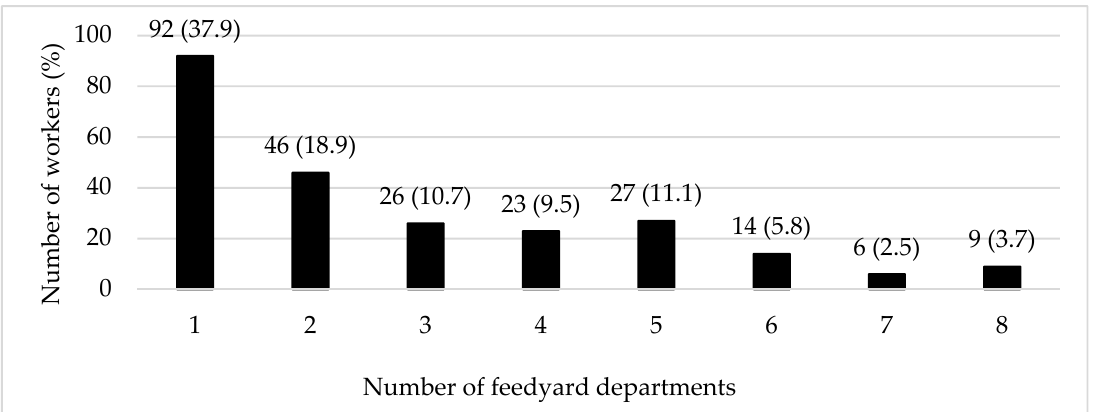
Figure 1. Distribution of feedyard workers by the number of different feedyard departments where they work.